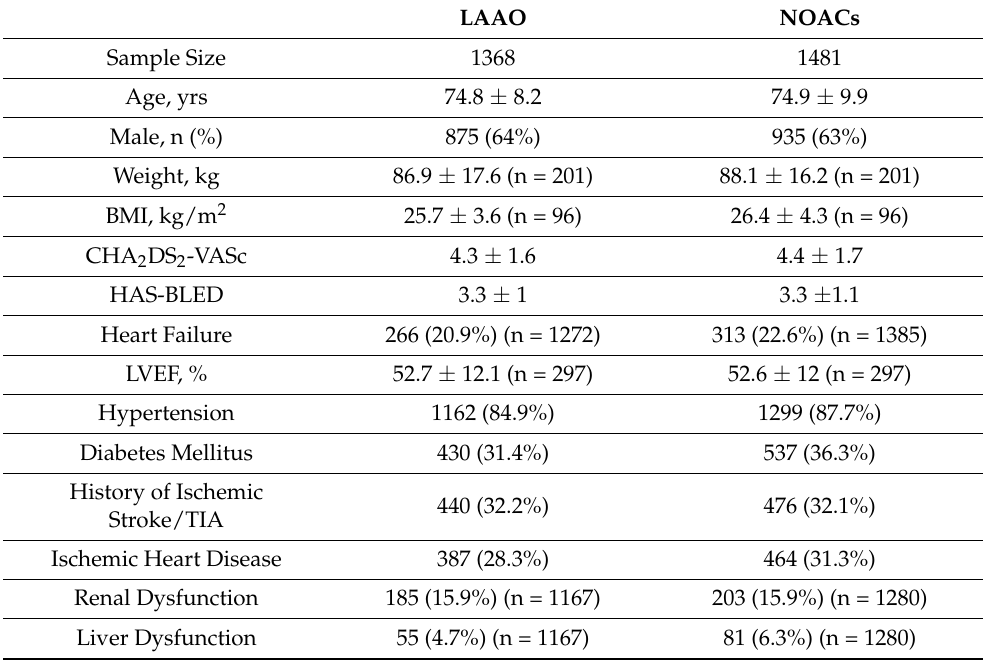
Table 2. Pooled baseline characteristics.